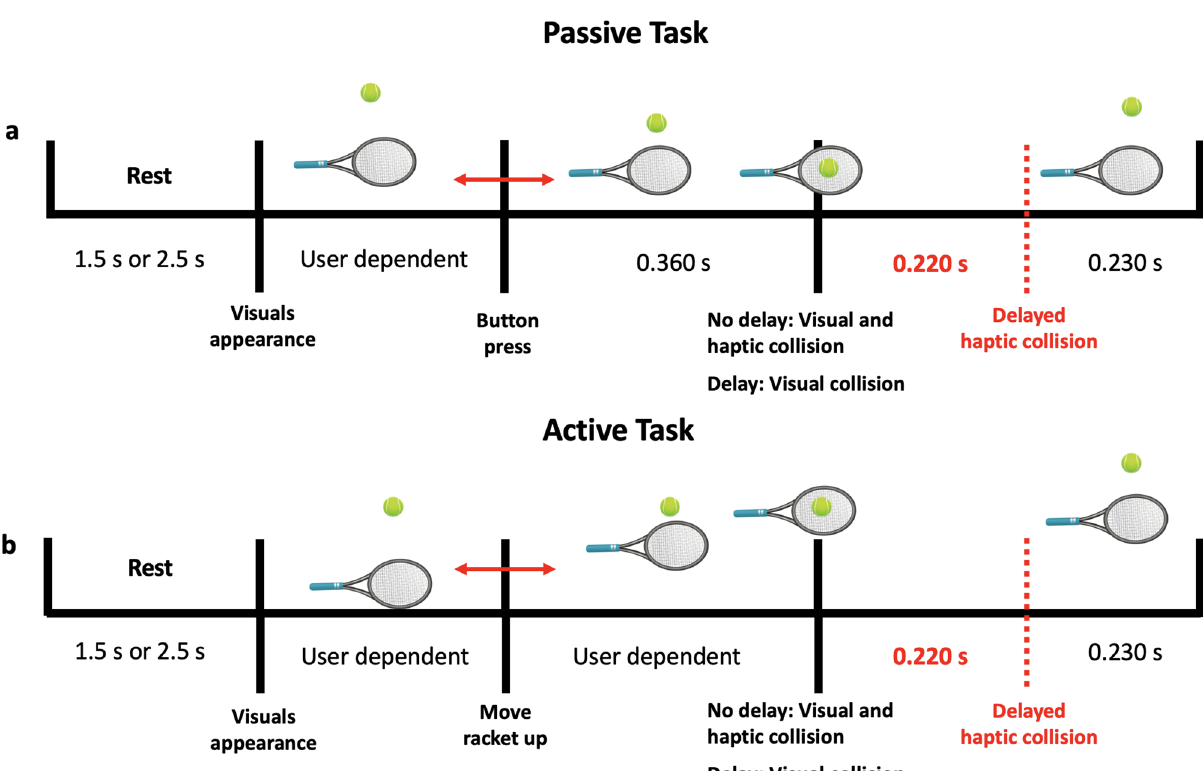
Figure 2. Schematic representation of the experimental task and the sequence of events. Haptic collision is either delayed by 220 ms or synchronous to the visual collision between the racket and the ball. Trials are divided as (50 trials are passive and synchronous, 50 trials are passive with haptic delay, 50 trials are active and synchronous, and 50 trials are active with haptic delay). ( a ) The passive task is initiated with a button press on the stylus of the haptic device. The ball will fall to collide with the racket ( b ) The active task is initiated with an actual movement of the stylus towards the ball. The time taken for the racket to hit the ball depends on the user’s